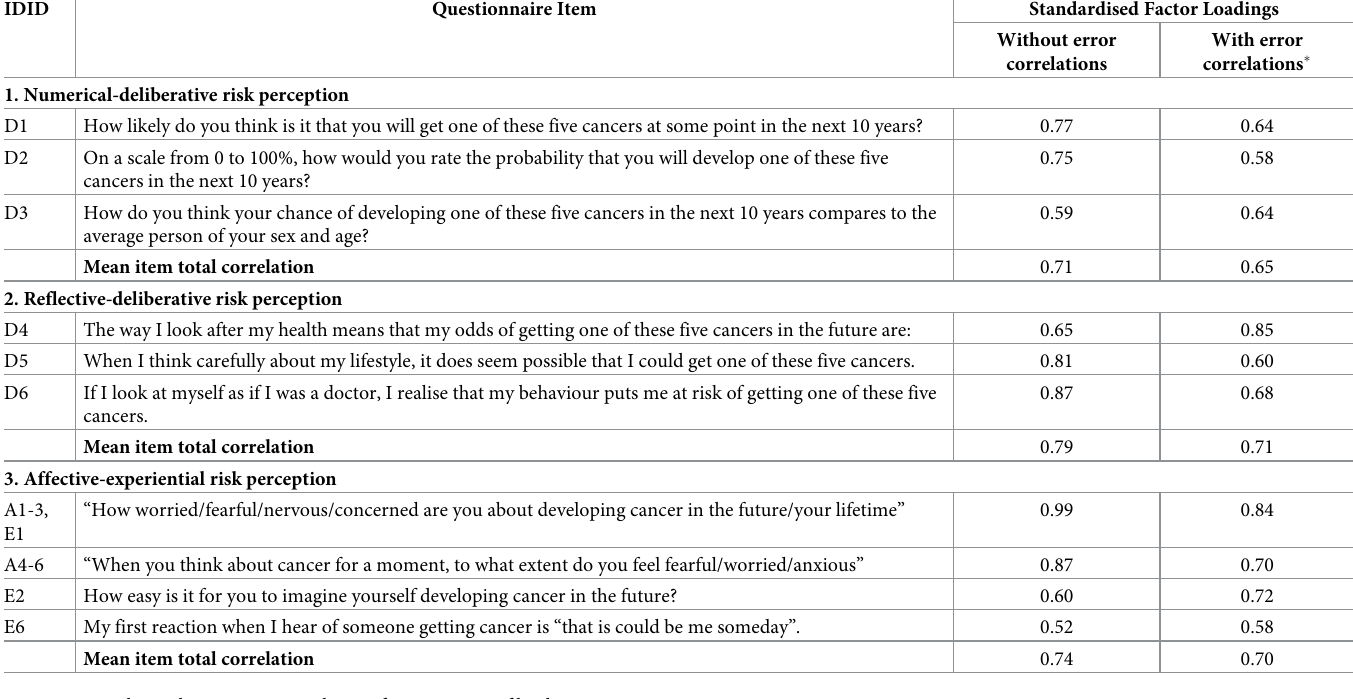
Table 6. CFA of the EFA-based model.